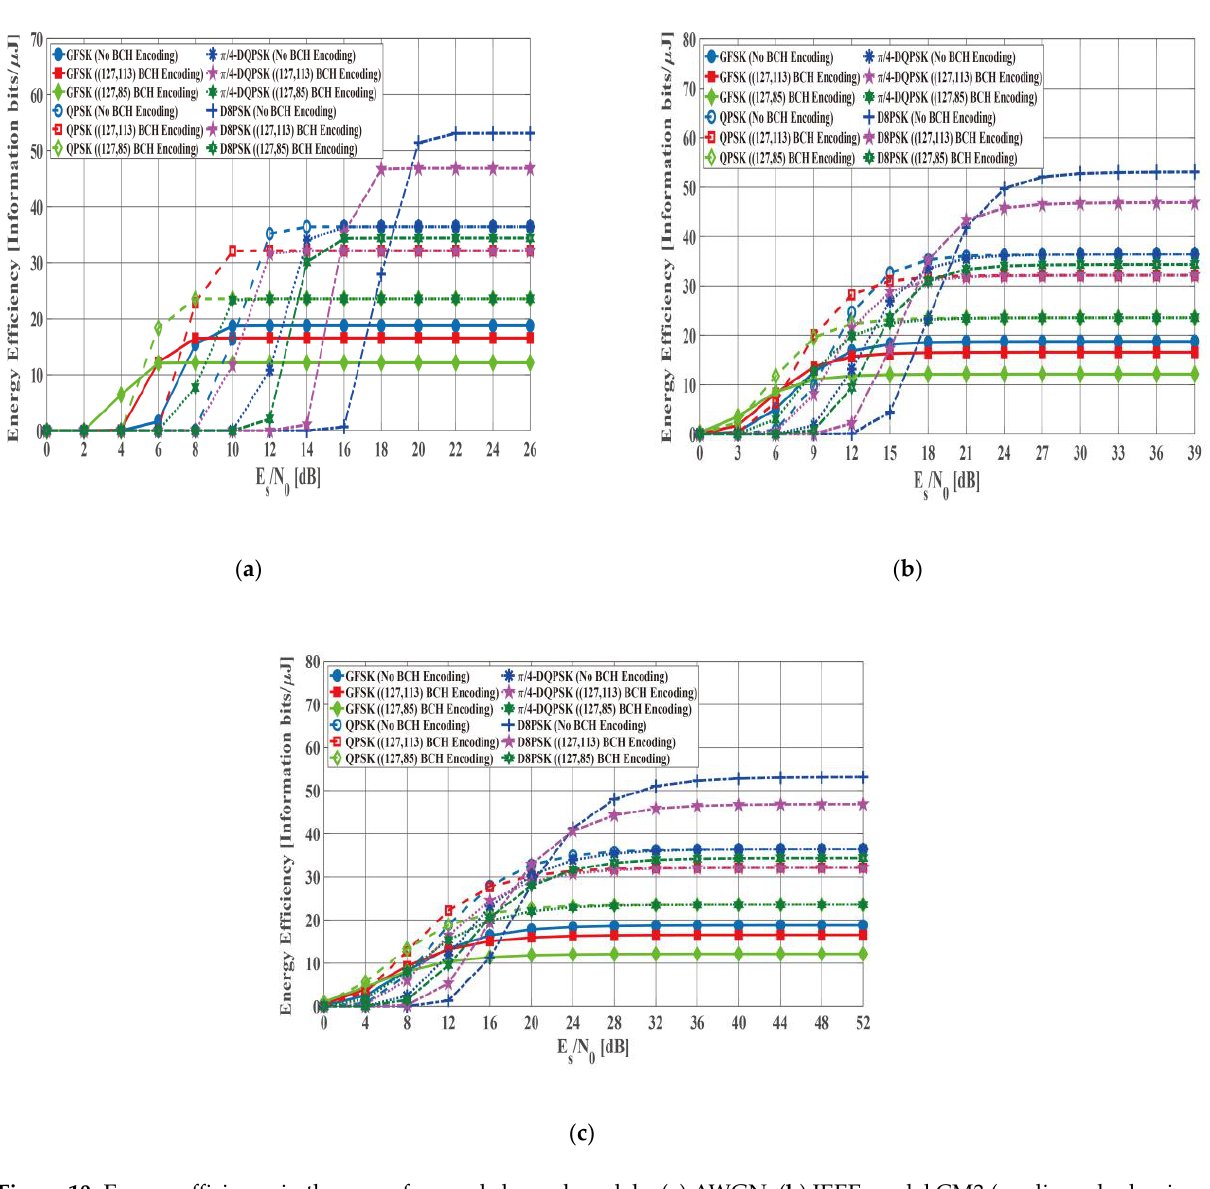
Figure 9. Packet error ratio in the case of several channel models. ( a ) AWGN. ( b ) IEEE model CM3 (medium shadowing case, K = 4.5). ( c ) IEEE model CM3 (strong shadowing case, K = 0.14).